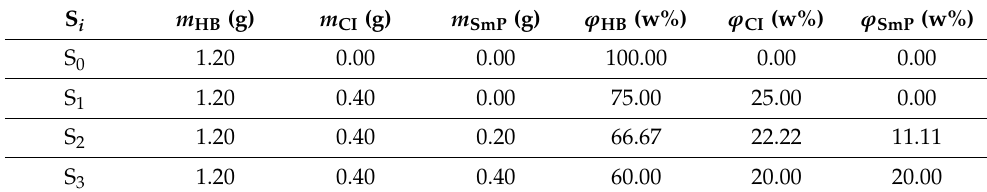
Table 1. Liquid magnetic suspensions .